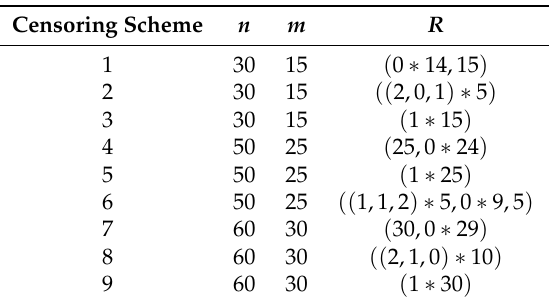
Table 1. Censoring schemes